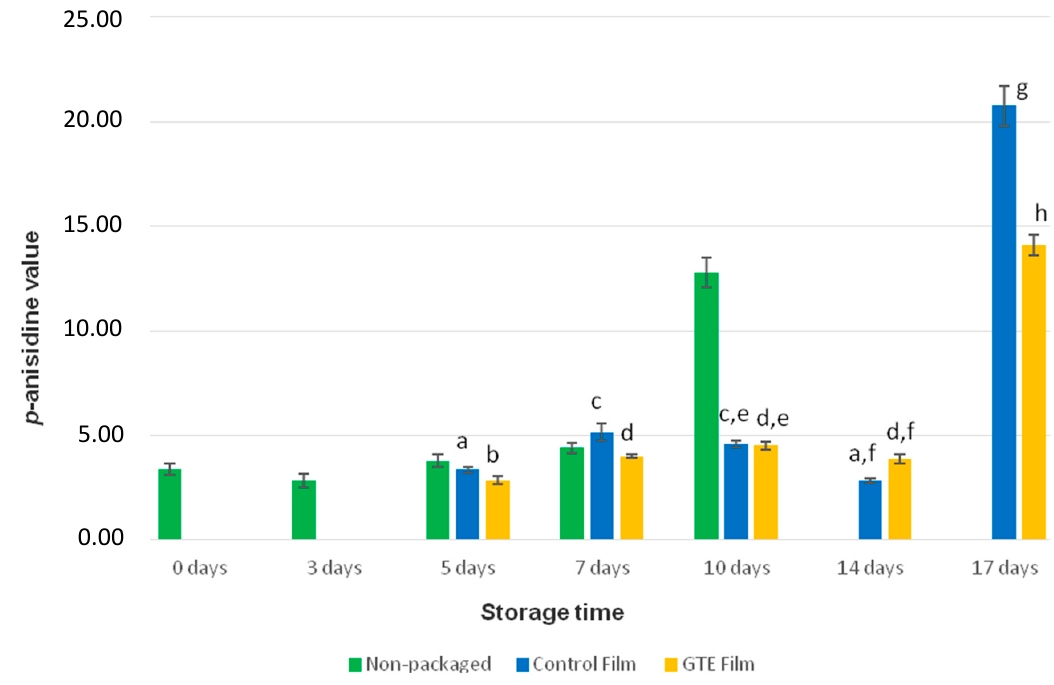
Figure 2. Results of p -anisidine value determination of fresh salmon samples packaged with the control film (without GTE), packaged with the active film (with GTE) and non-packaged salmon. Different letters are for significant differences ( p < 0.05).